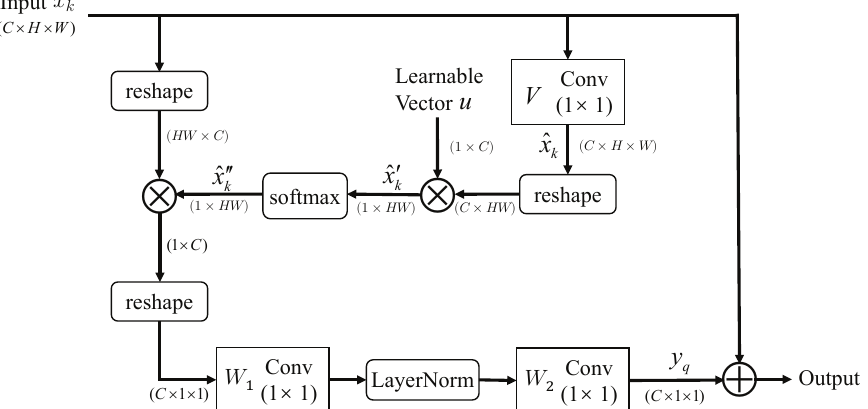
Figure 2. The flowchart of attention weight calculation in the proposed method. The numbers in parentheses denote the shape of the feature map.